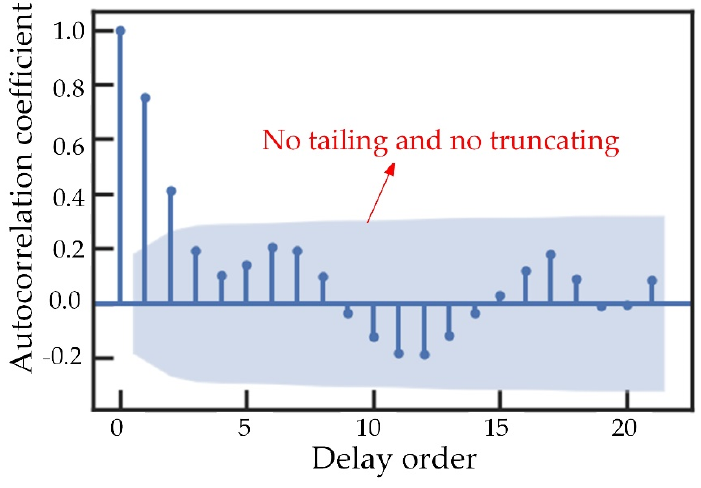
Figure 6. The autocorrelation diagram of the bandwidth occupancy rate of link l j .